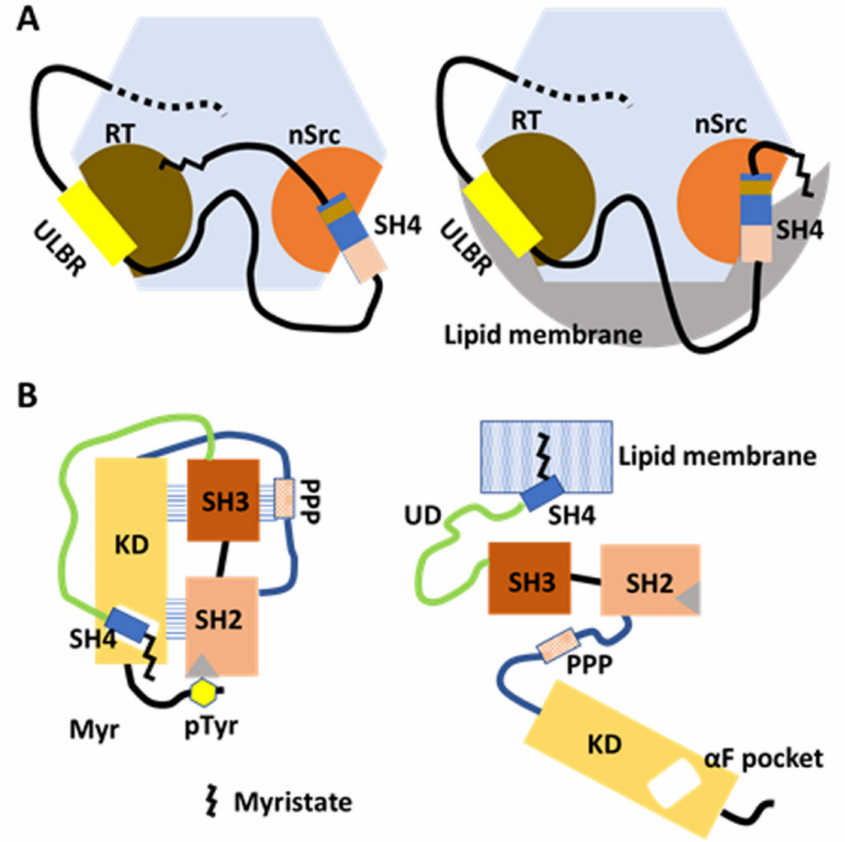
Figure 3. Membrane anchoring and intracellular transport modulated by myristate/SH3 interaction in the FIMC and by SH4/KD binding in the canonical model. ( A ) Model based on NMR structural analysis of myristoylated FIMC. The N-myristoyl group interacts with hydrophobic residues around the RT loop of SH3 in the absence of lipid membranes. The FIMC structure is maintained under myristoylation (left). In the presence of lipid membranes, the N-myristoyl group is detached from the SH3 and inserts into the membrane (right). UD contributes to the maintenance of the fuzzy complex in the absence and presence of lipid membranes. ( B ) Model based on comprehensive mutagenesis with chemical genetics. In the absence of lipids, SH4 binds the α F pocket, leading to the formation of the folded SH3/SH2/KD complex in the canonical model. Interaction between the N-terminal myristate and the α F-pocket in the C-lobe of KD is not confirmed (left). In the presence of lipid membranes, the N-myristoyl group binds to the lipid membrane to anchor the Src protein to the membrane